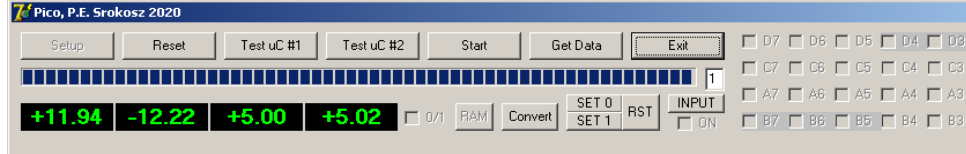
Figure 11. The control system and the measurement system: ( a ) Photograph; ( b ) Schematic diagram. The generator consisted of a microcontroller to control the shape of the impulses (8-bit AVR) and a system to control the voltage amplitude and pulse triggering time.